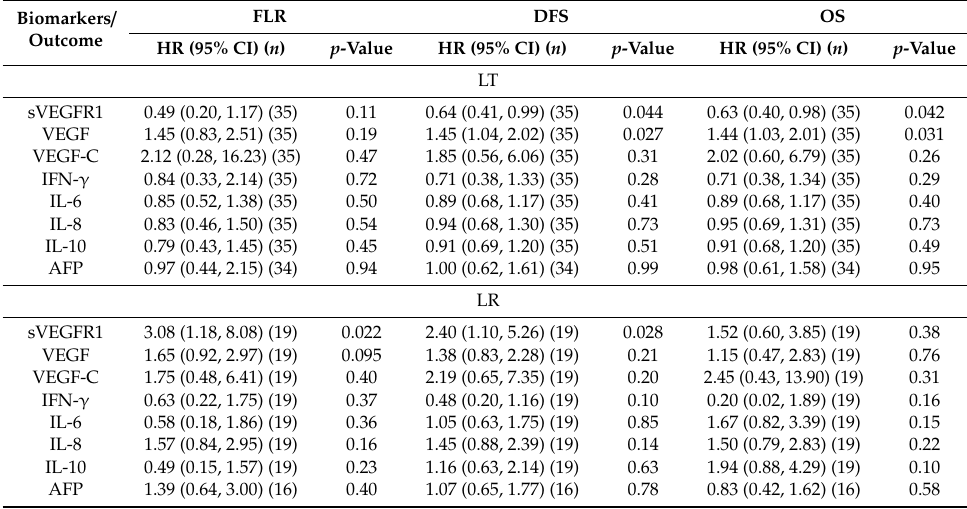
Table 5. Association between selected plasma biomarkers and freedom of liver recurrence (FLR), disease-free survival (DFS) and overall survival (OS) in hepatocellular carcinoma patients within Milan criteria who underwent surgical treatments. p -Value from Wald test in a univariable Cox regression using log-transformed